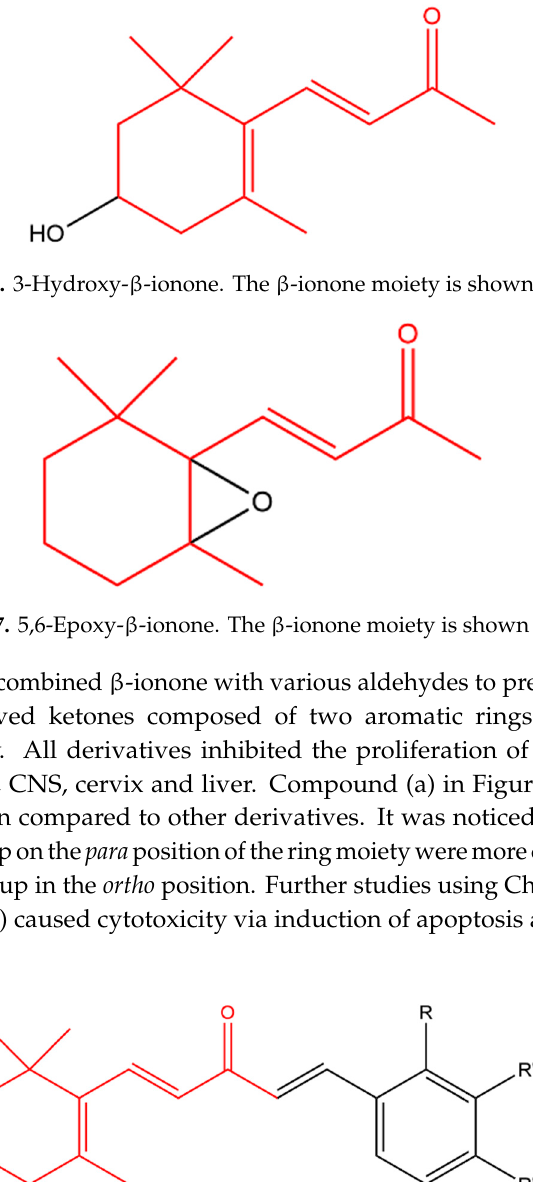
Figure 8. (Compound a ). R = H, R’ = H, R’’ = NO 2 ; [(1 E ,4 E )-1-(4-nitrophenyl)-5-(2,6,6-